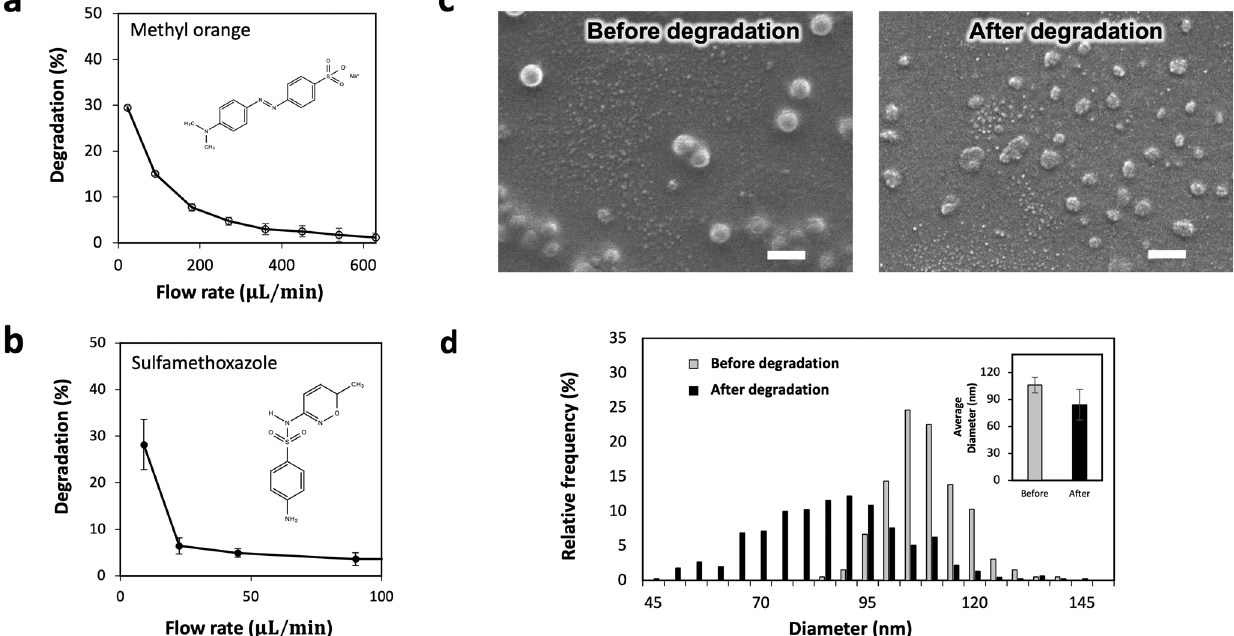
Fig. 6 Water puri fi cation capacity by photocatalytic degradation. a The MO degradation and b the SMX degradation of the TiO 2 nanohelix- based microreactor. The error bars represent the standard deviations of three samples. c SEM images of polystyrene particles before and after photocatalytic degradation. d PS particle diameter distribution before and after degradation. The inset shows the average diameter of the particles. Scale bar: 200